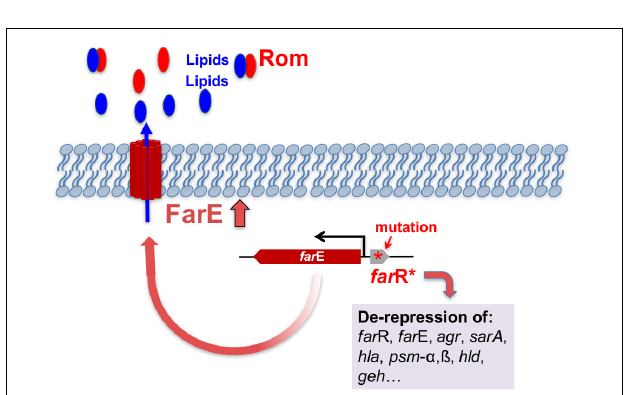
FIGURE 6 | Model for FarE mediated resistance to Rom in the Rom R clone. In the Rom R clone farR is inactivated by the point mutation that leads to an amino acid exchange (Cys116/Arg) in the FarR regulator protein. FarR, acts not only as a repressor of its own farR gene but also represses farE . The mutation in farR indicated by ( ∗ ) leads to inactivation of FarR and consequently to derepression of farE and many other genes (including farR , agr , sarA , hla , psm - α , β , hld , geh ). Derepression of farE causes over-expression of FarE. We propose that FarE acts as an exporter of lipids that interact with Rom thus causing neutralization of Rom and leading to high Rom